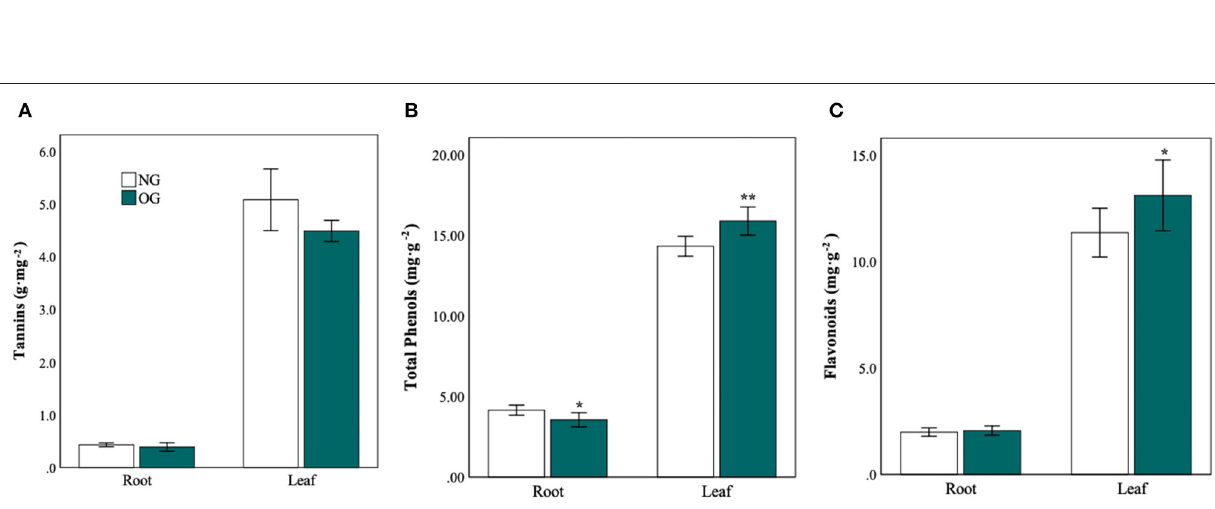
Frontiers in Plant Science | www.frontiersin.org